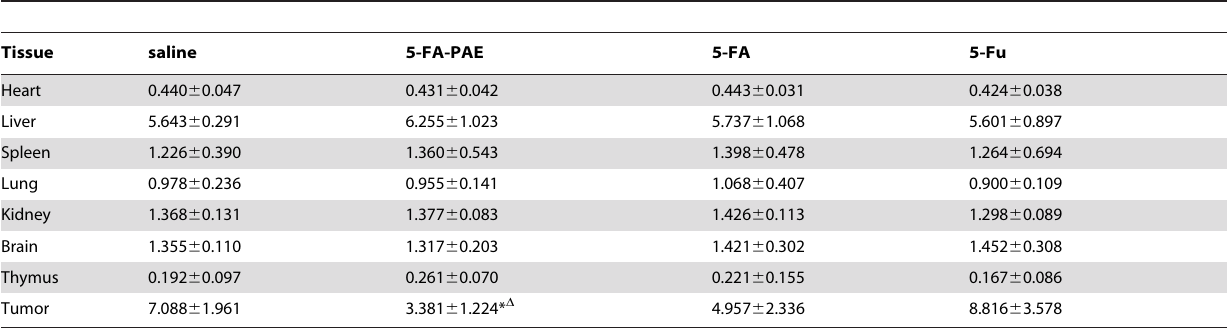
Table 5. The organ/body weight index of mice administrated with saline, 5-Fu, 5-FA or 5-FA-PAE.